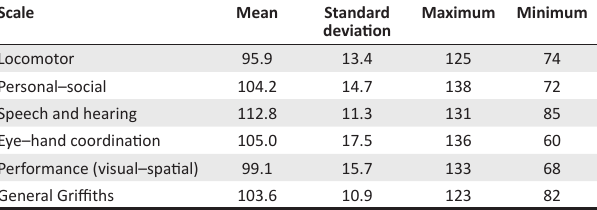
TABLE 2: Scores on Griffiths mental development scales (quotients) at mean age of 11.5 months ( n = 29). Scale